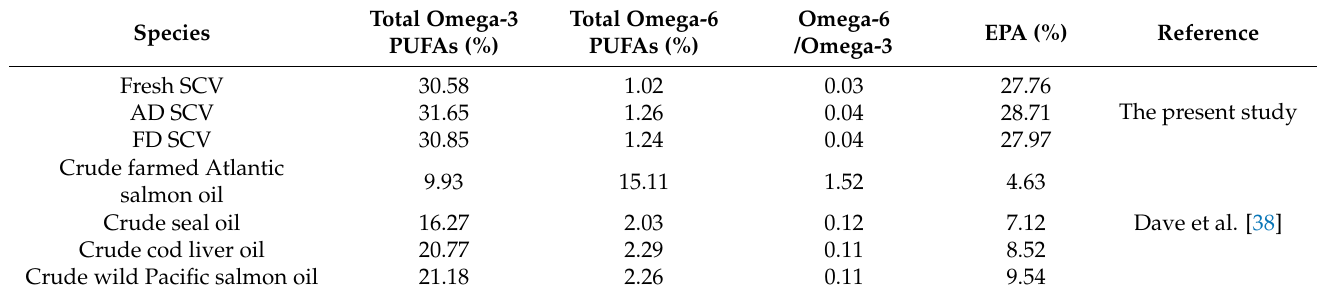
Table 4. Comparison of omega-3 PUFAs, omega-6 PUFAs, and EPA in total lipids from the present study and literature.